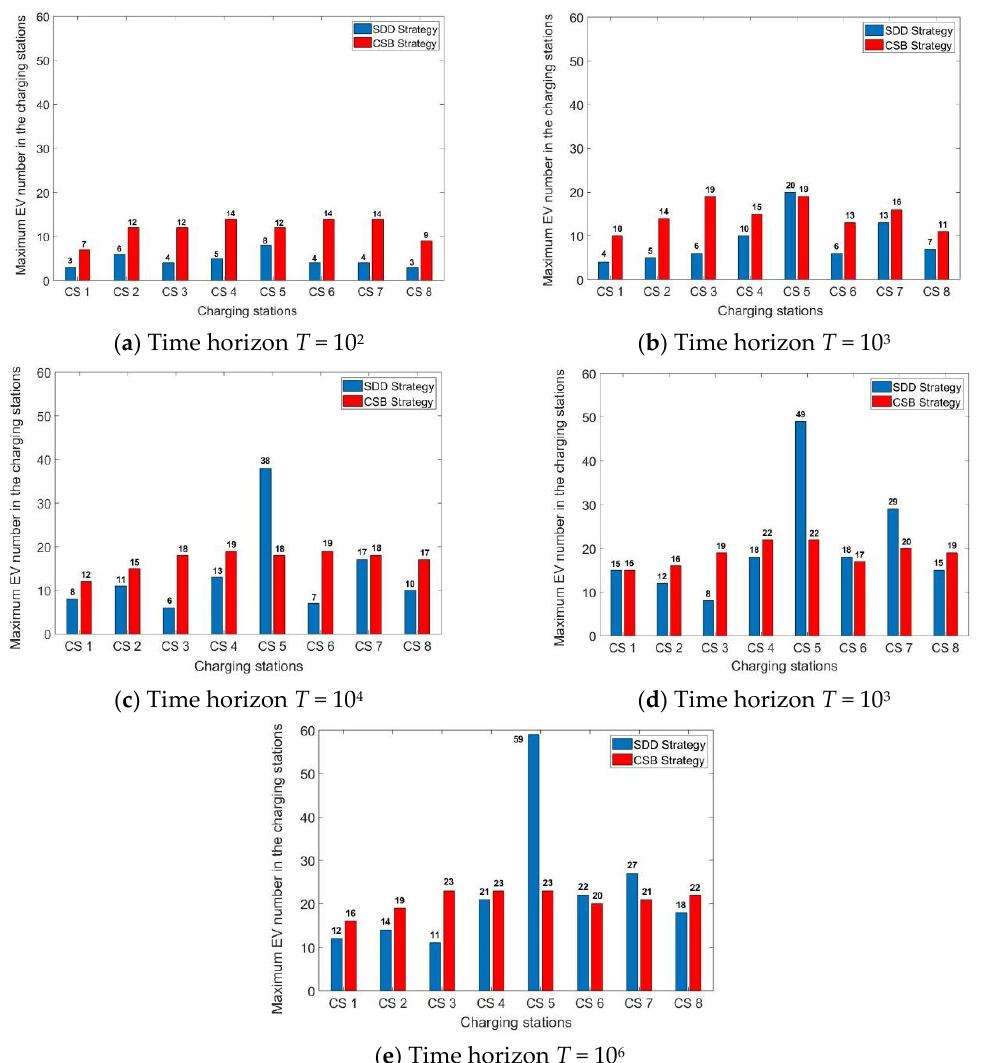
Figure 7. Maximum EV number at each charging station during different time horizons T.